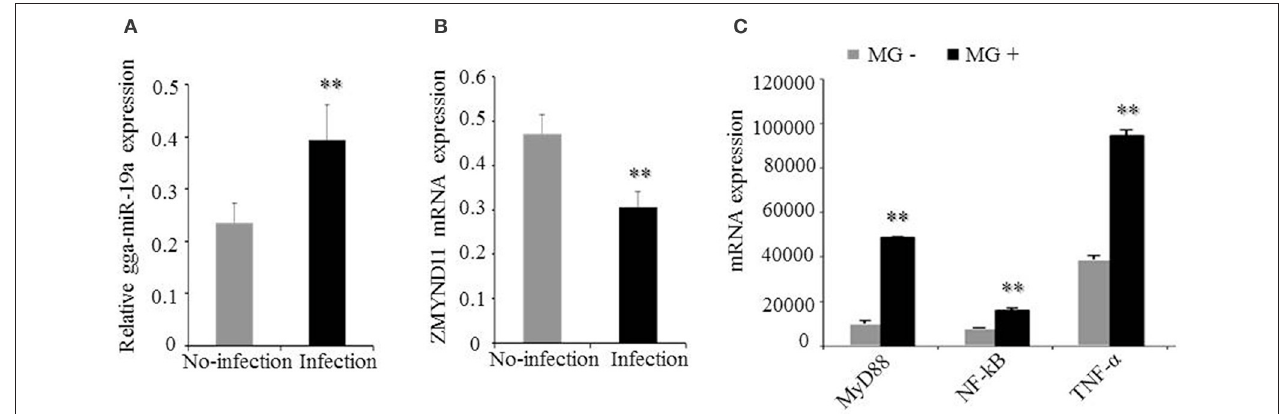
FIGURE 8 | Effects of MG infection on the expression of gga-miR-19a, ZMYND11, NF- κ B, TNF- α , and MyD88 in DF-1 cells. The DF-1 cells were infected with MG-HS as described in the Material and Methods, and the total RNA was extracted. (A) gga-miR-19a expression was assessed by RT-qPCR, using 5S-rRNA as an internal quantitative control; (B) ZMYND11 mRNA expression was assessed by RT-qPCR, using GAPDH as an internal quantitative control; (C) NF- κ B, TNF- α and MyD88 mRNA expression was assessed by RT-qPCR, using GAPDH as an internal quantitative control. All values are represented as the mean ± SD of three independent experiments in triplicate. Significant differences are denoted as ** P < 0.01.